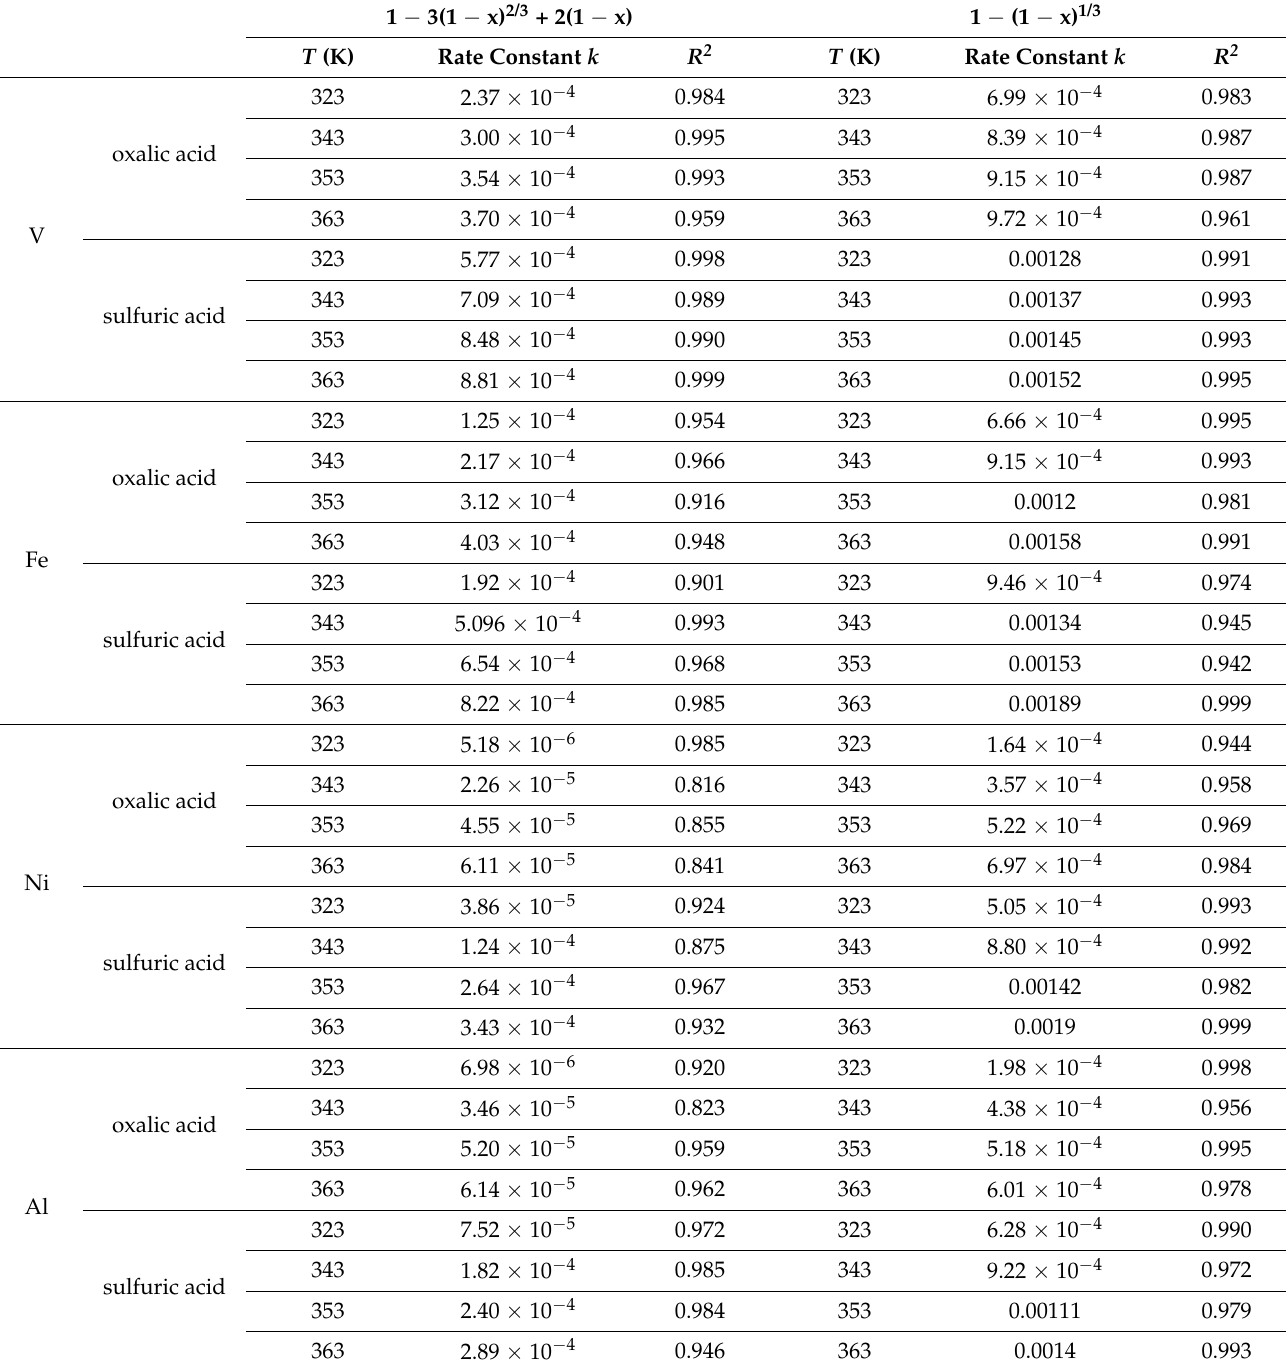
Table 1. Kinetic parameters at various leaching temperatures using different kinetic